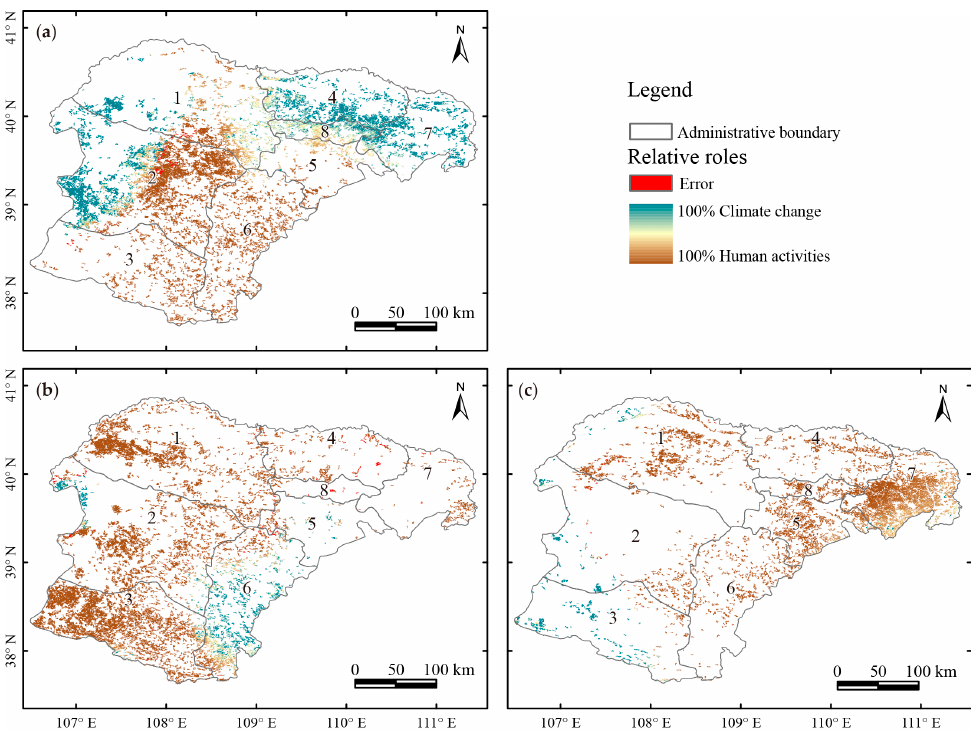
Figure 6. The relative roles of climate change and human activities in desertification reversion for ( a )